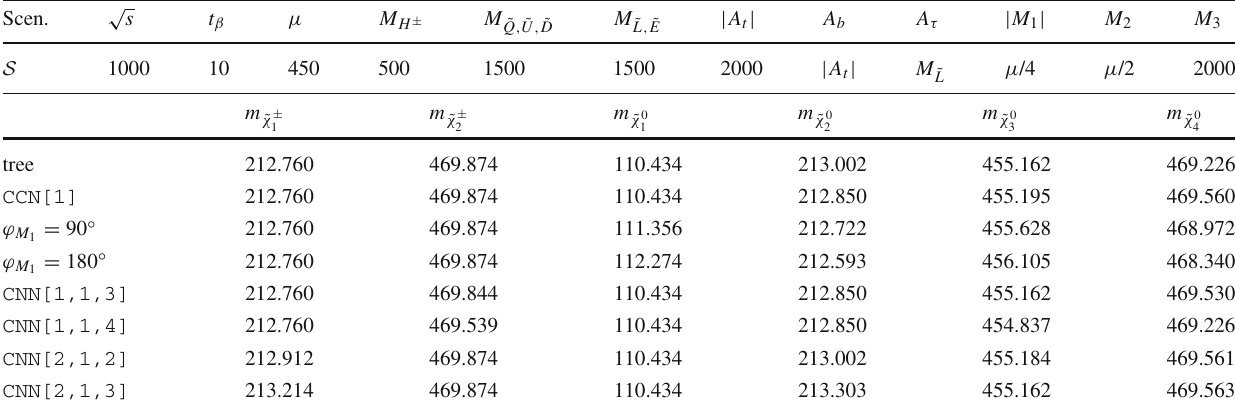
Table 2 MSSM default parameters for the numerical investigation; all parameters (except of t β ) are in GeV. The values for the trilinear sfermion Higgs couplings, A t , b ,τ are chosen to be real and such that charge- and/or color-breaking minima are avoided [96–102]. (It should be noted that we chose common values for the three sfermion genera-